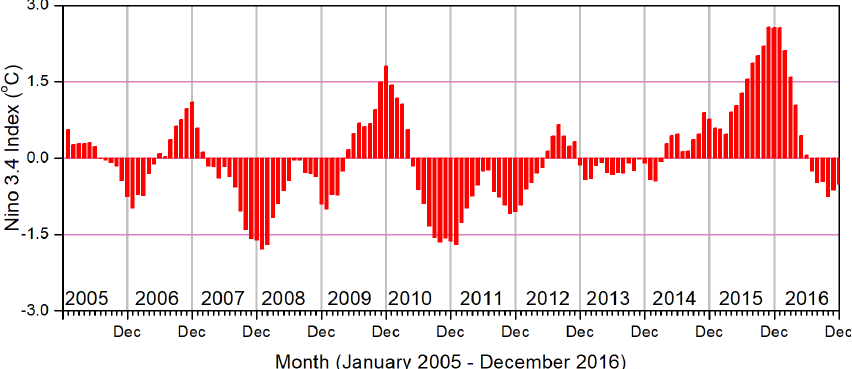
Figure 1. Temporal evolution of observed Niño 3.4 index data from January 2005 to December 2016.